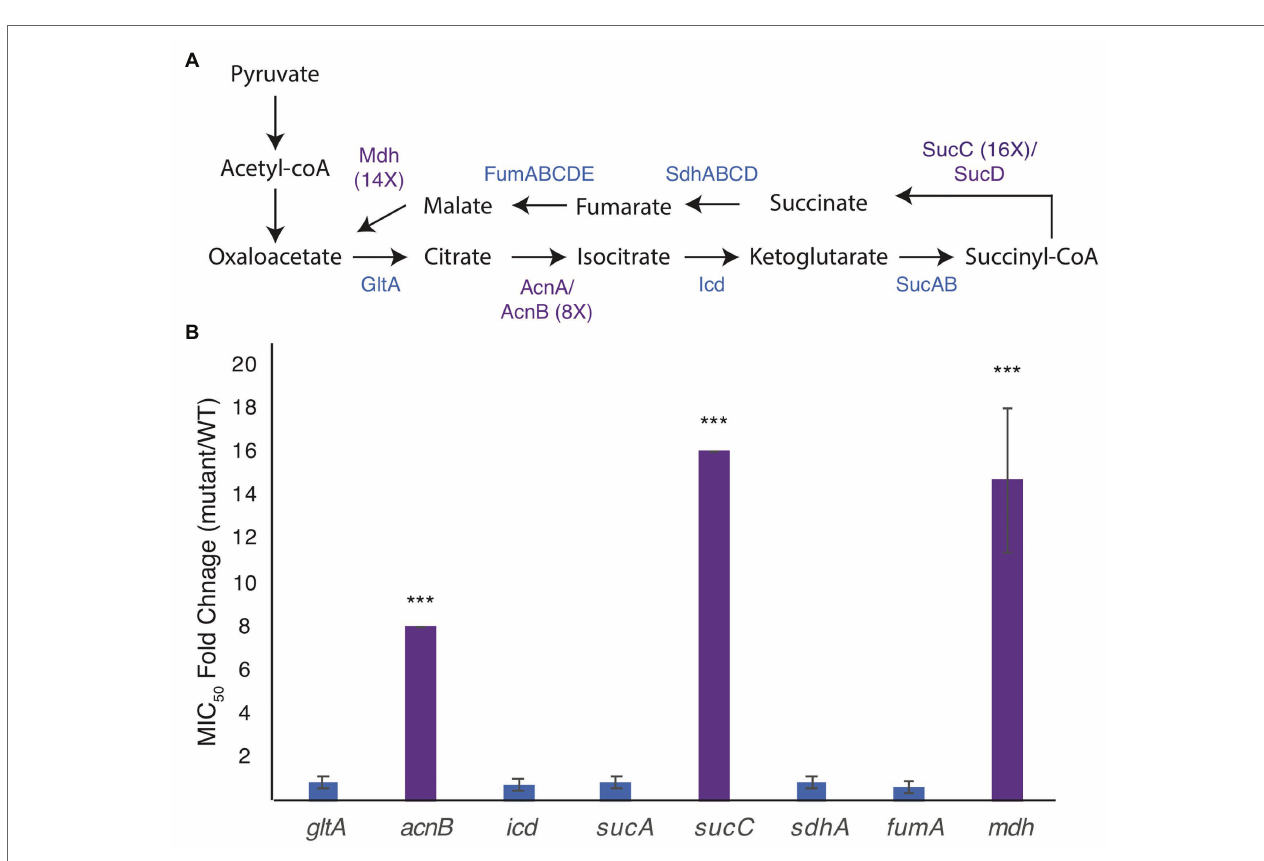
FIGURE 1 | Mutations in the genes of the tricarboxylic acid (TCA) cycle increase the minimal inhibitory concentration (MIC) of A22 (MIC A22 ). (A) Model of the TCA cycle. Proteins in purple have higher MIC A22 when the associated gene is deleted. (B) MIC A22 fold change of mutants in the TCA cycle. Only malate